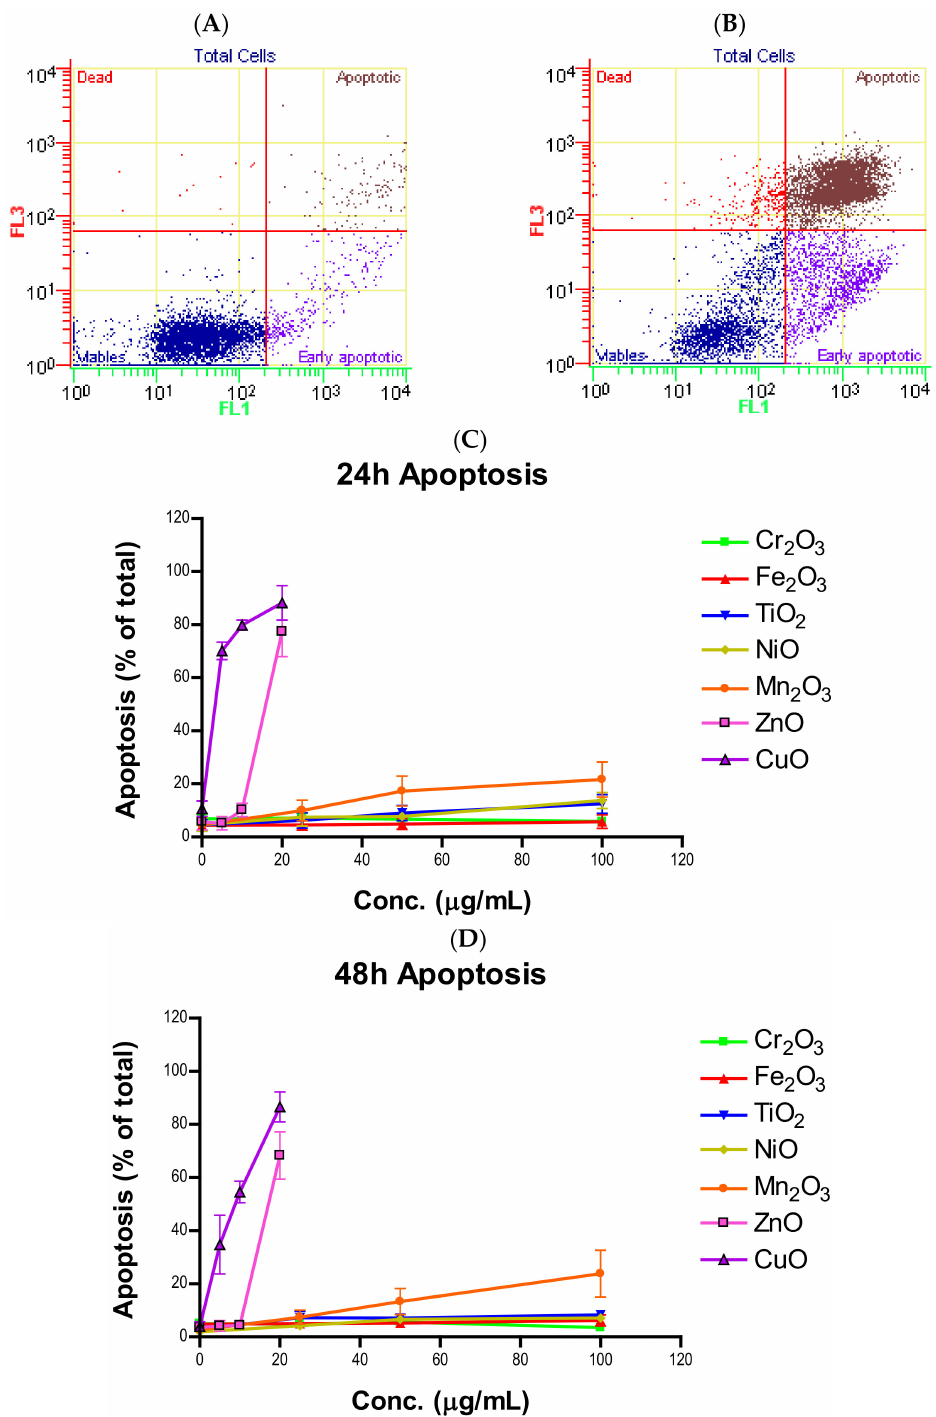
Figure 2. Flow cytometry gating of cells treated with ( A ) 0 and ( B ) 20 µ g / mL of ZnO after 24 h. Total apoptosis of A549 cells after ( C ) 24- or ( D ) 48-h exposure to various concentrations of one of seven